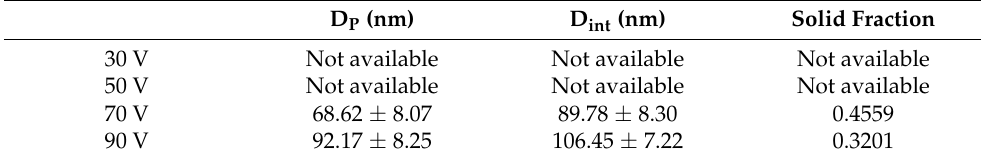
Table 3. Characterization of the oxide film structure of stainless steel 316L.